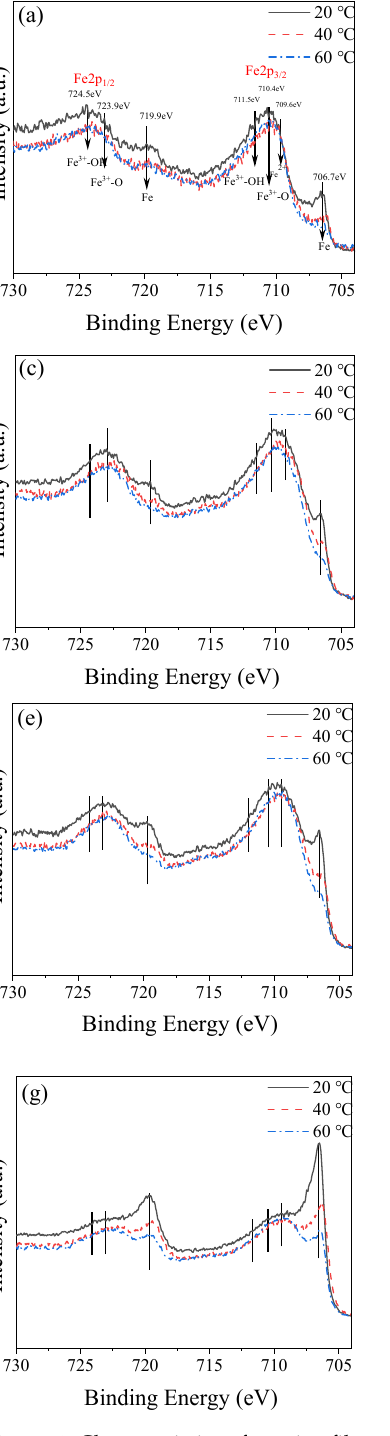
Figure 4. Characteristics of passive film at different depths: ( a , c , e , g ) are the XPS diagram of iron, and ( b , d , f , h ) are the XPS diagram of oxygen.